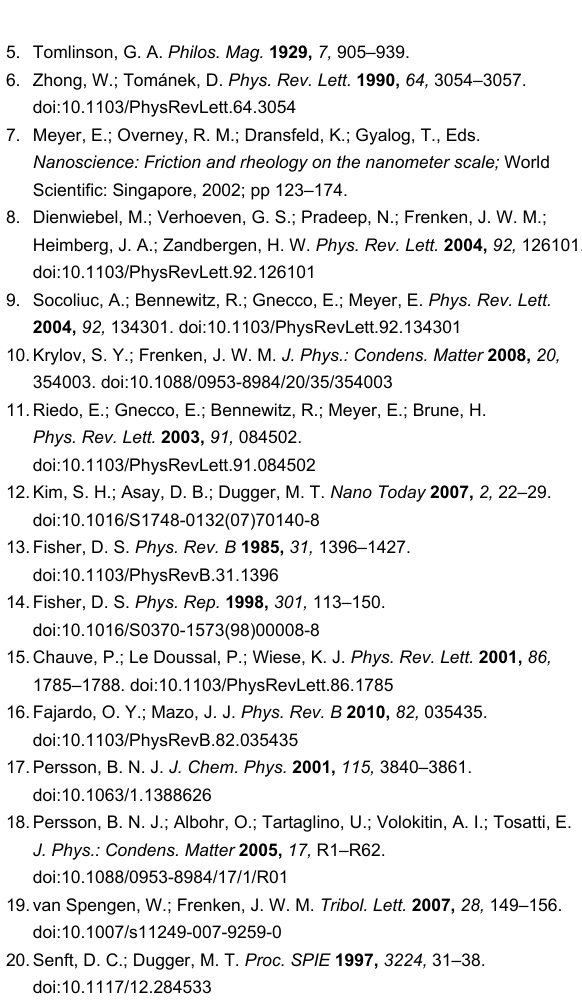
Figure 10: Calculated and measured friction reduction as a function of vibration amplitude (frequency held constant at 500 Hz, left figure) and frequency (5 V pp amplitude, right figure).